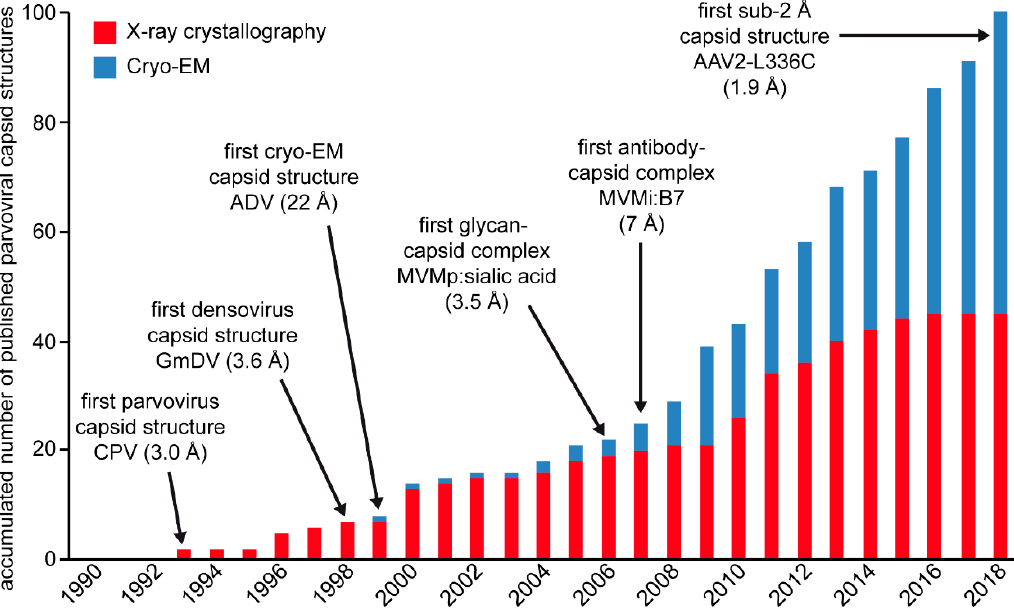
Figure 15. Overview of published parvoviral capsid structures since 1990. Structures determined by X-ray crystallography are shown in red and structures determined by cryo-EM in blue. Important milestones of structural parvovirology are indicated.